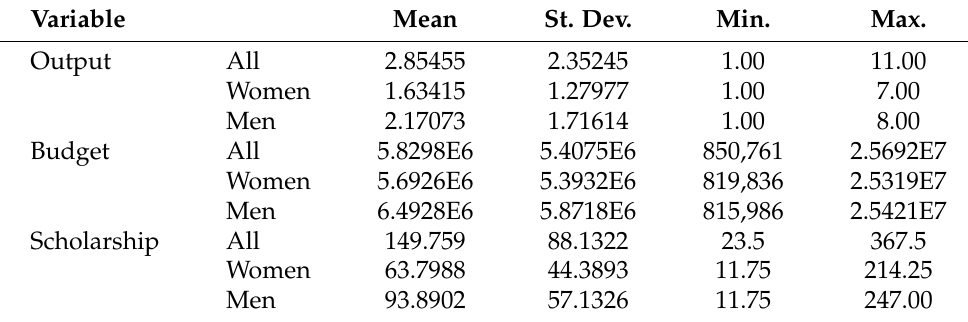
Table 3. Summary of descriptive statistics of data used considering the Olympic years 2008, 2012, and